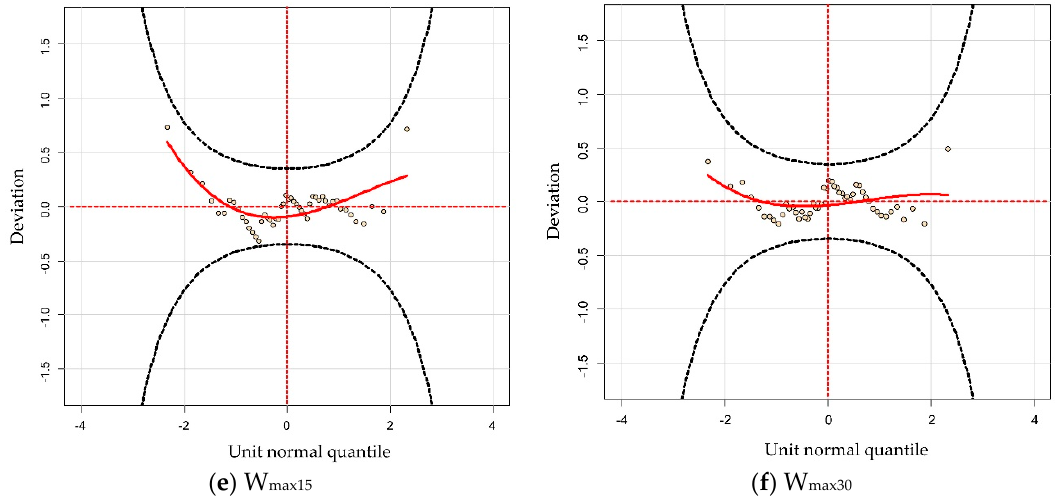
Figure 4. Worm plots of model 1 residuals. The two black dotted lines correspond to the 95% confident limits. Table 6. Residual distribution moments and Filliben coefficients for optimal fitting distribution of snowmelt flood time series (model